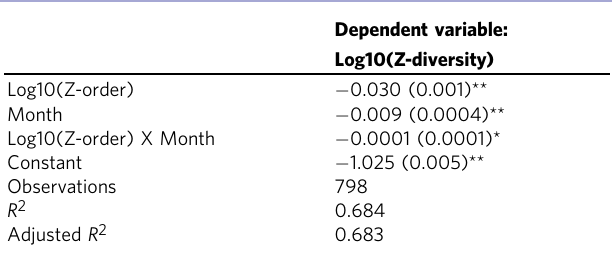
Table 1 Regression fi t of Zeta diversity as a function of time, logarithm of the order, and their